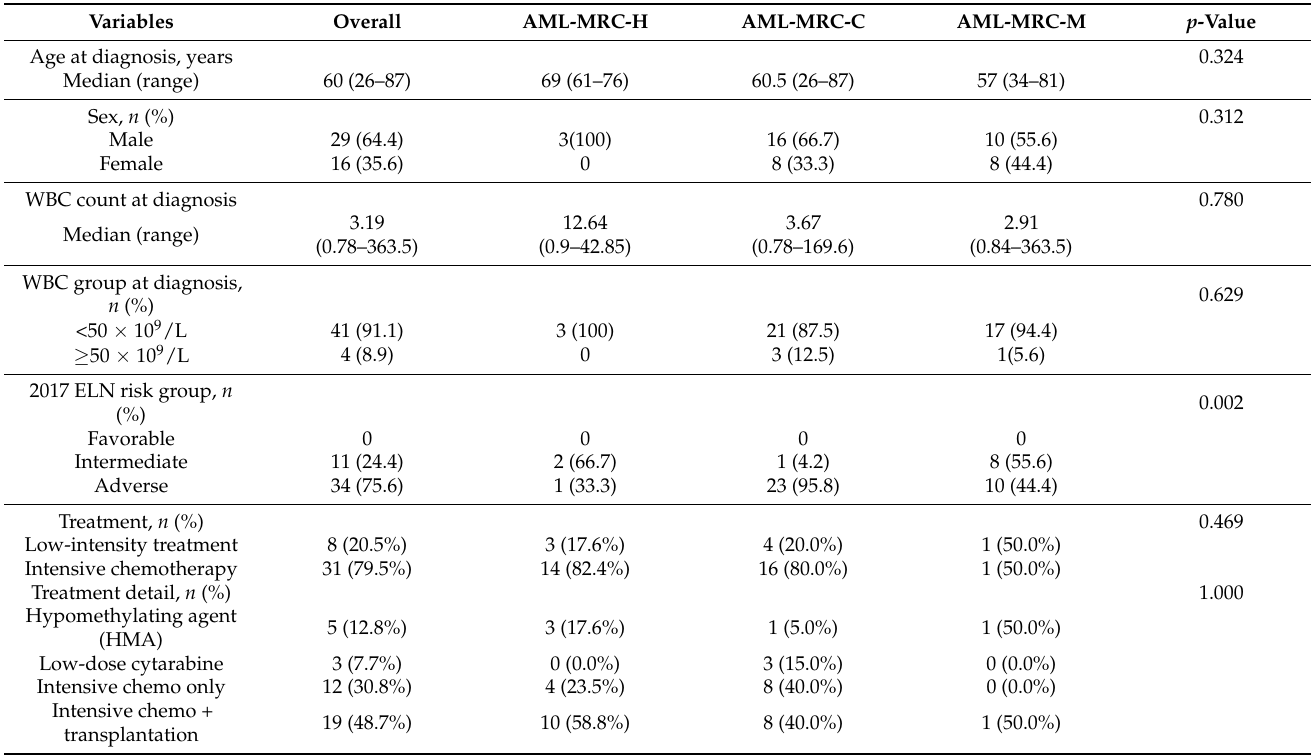
Table 1. Patient, disease, and treatment characteristics according to acute myeloid leukemia with myelodysplasia-related changes (AML-MRC)